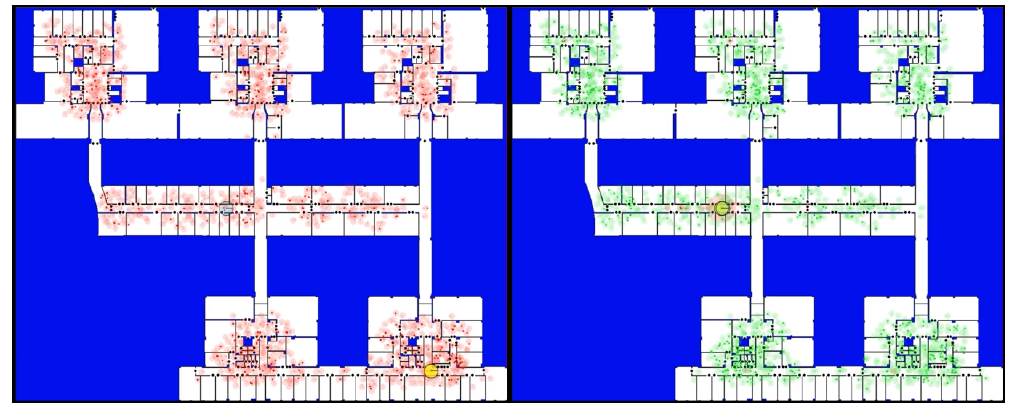
Figure 6. At the figure the localization based on SRL (left) is compared with our ESL filter (right). It can be seen that the robot on SRL is posed wrongly at a different position (bottom on the right) while on our ESL the robot is “strongly” placed (the red circle, in the middle, is large).